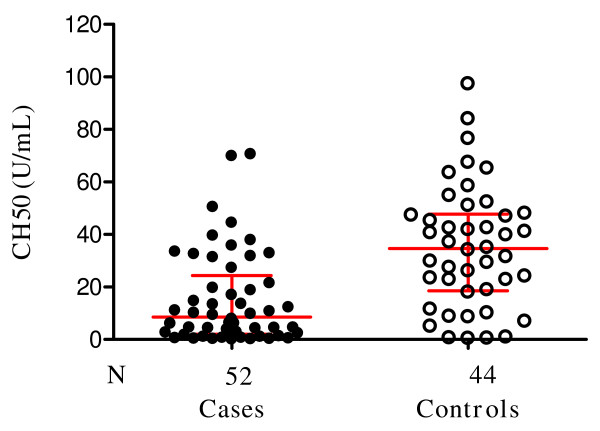
Scatter plot showing the median and interquartile C hemolytic titer in children with severe malaria anemia (cases) and those with uncomplicated malaria (controls). The CH50 in cases was 8.6 U/mL (2.1 to 24.4) compared to 34.6 U/mL (18.5 to 47.7) in the controls (P < 0.001). Wilcoxon matched-pairs signed-ranks test was performed with the 44 paired samples.